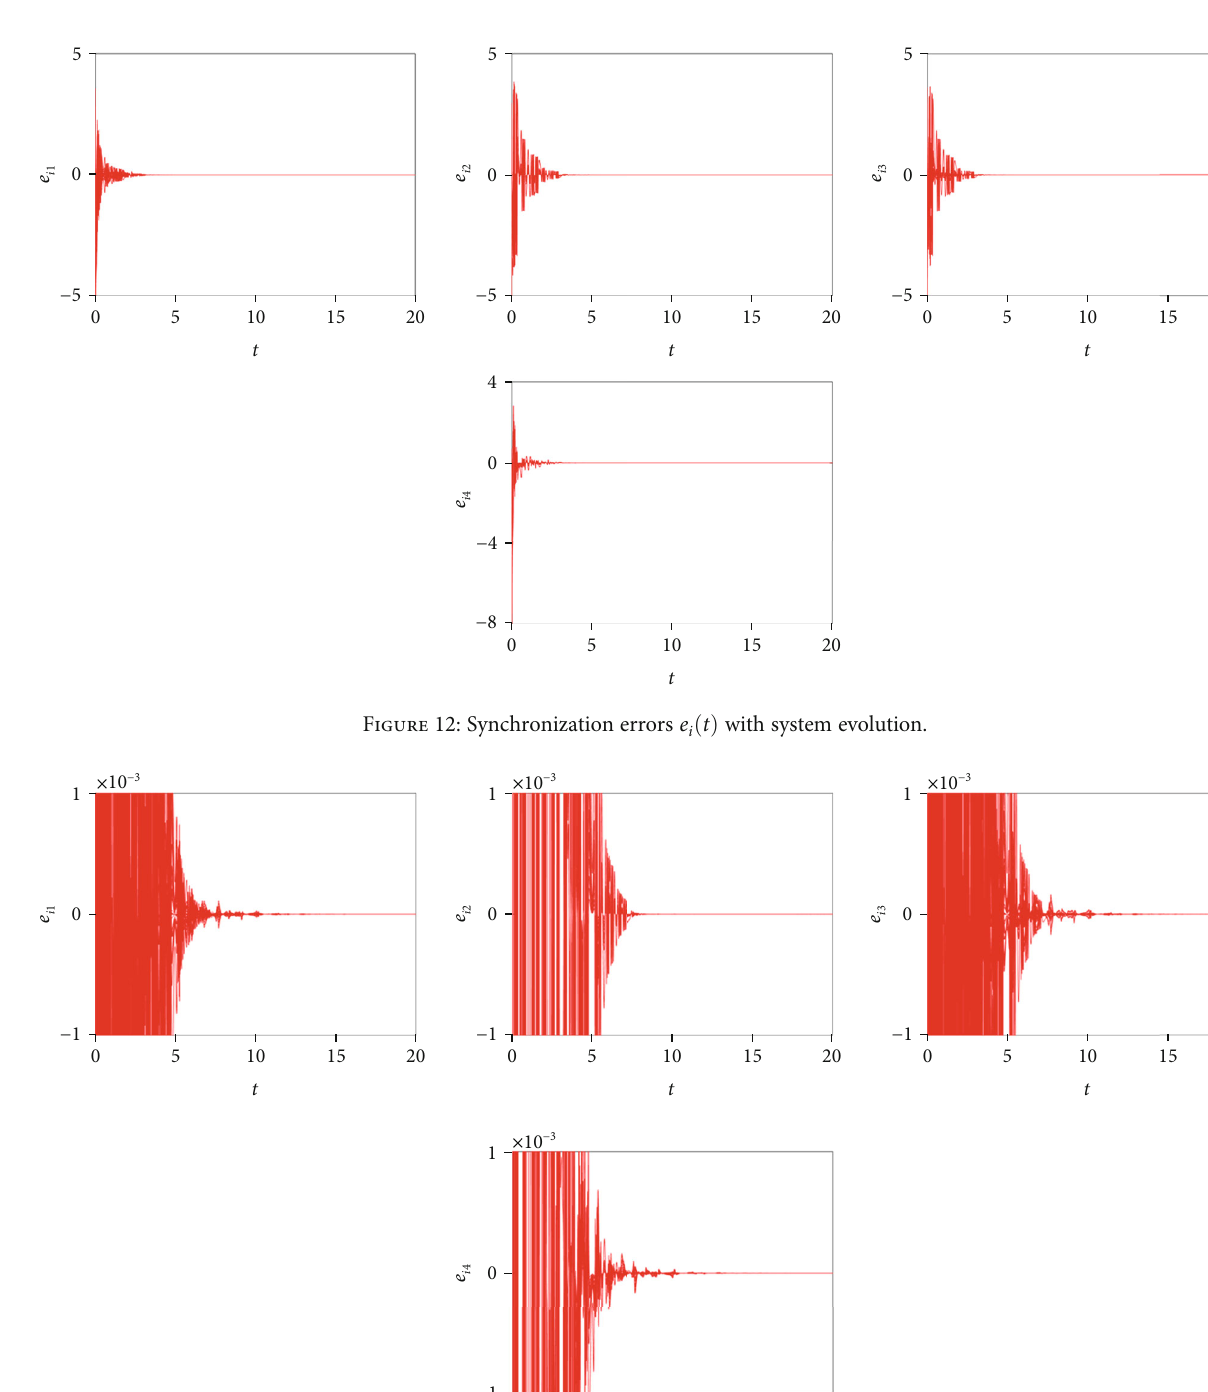
Figure 13: Partial ampli fi cation of synchronization errors e